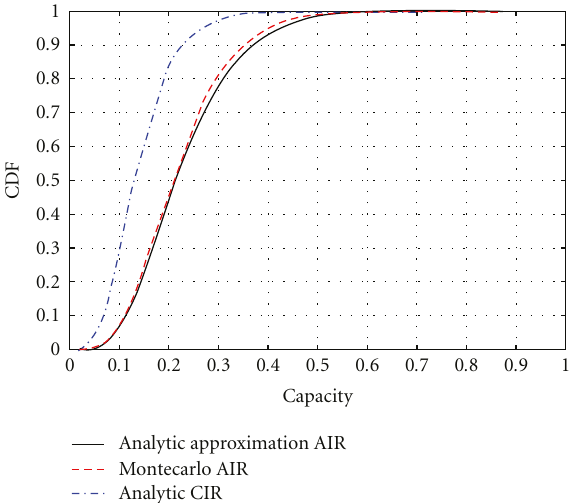
Figure 5: Comparison between cumulative density functions in the system with constant information rate (CIR), adaptive information rate (AIR) and Montecarlo simulation of AIR. For each value of R , the constant rate system has a probability not to achieve a rate equal or greater that R which is higher with respect to our system. Equivalently, our system will be transmitting at a rate higher than R for a greater percentage of time.